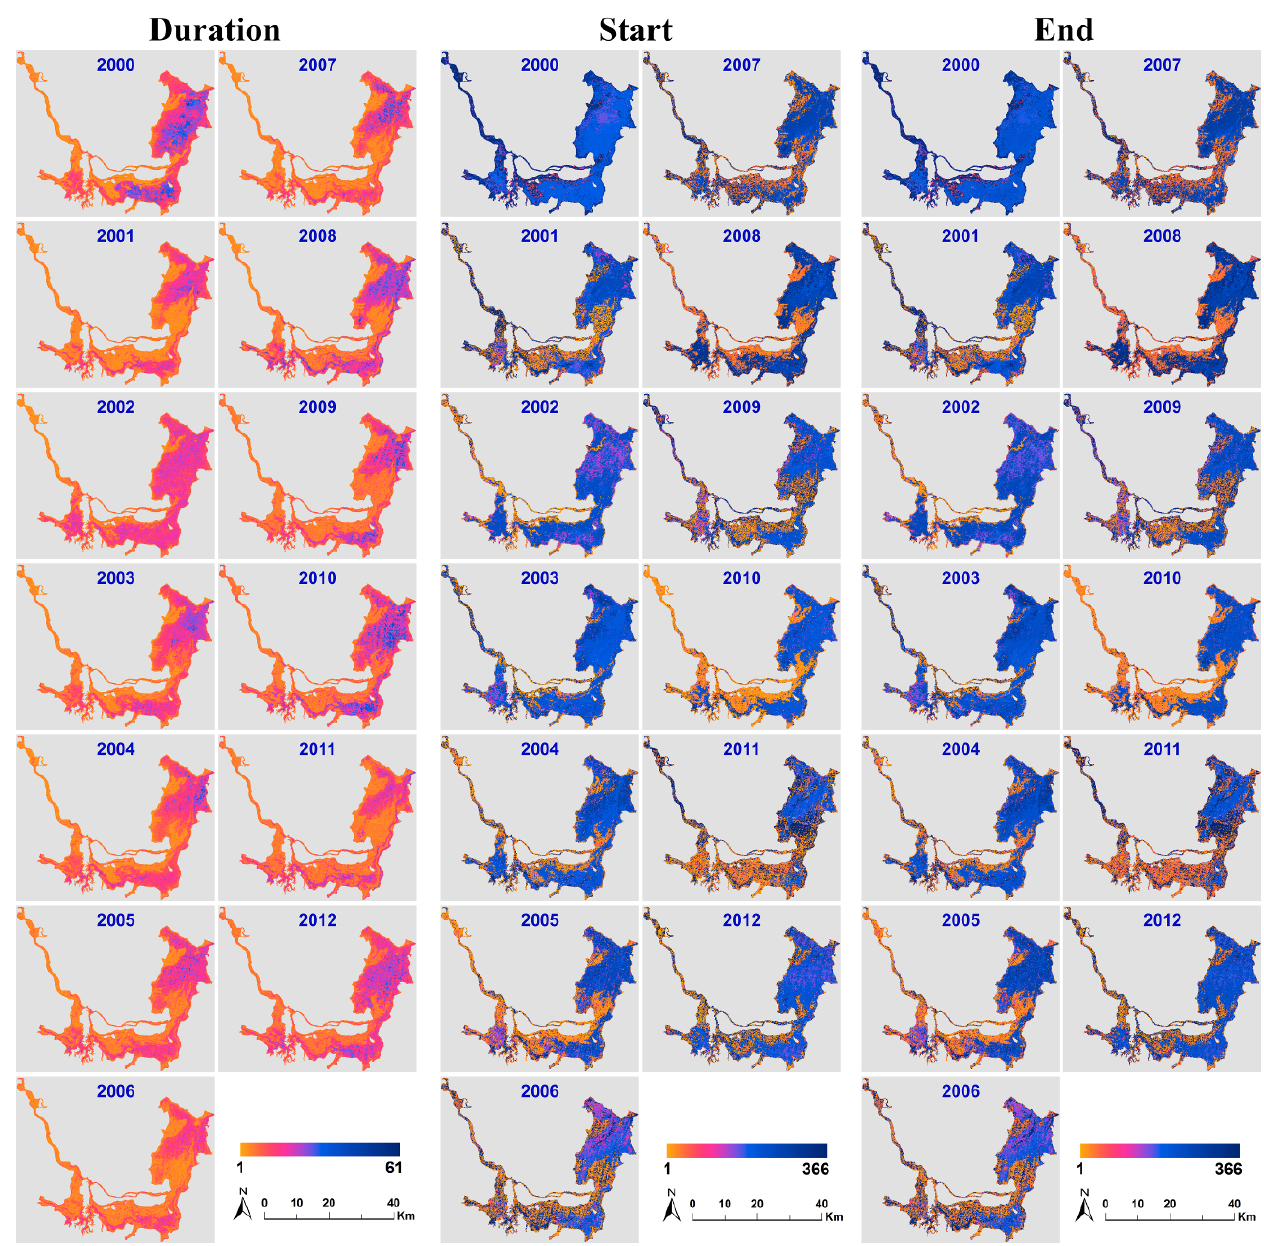
Figure 9. Spatial and temporal changes in the duration and start/end date of the largest inundation cycle from 2000 to 2012 in the Dongting